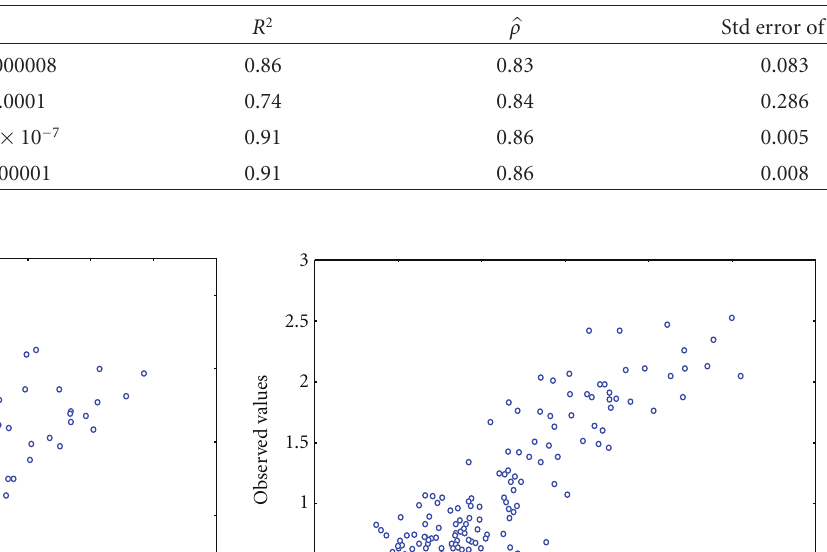
Table 2: Values of the parameter c , standard errors, R 2 , (cid:11) ρ and standard error of the fit resulting from the fittings of the isometric models of (2) or (9).